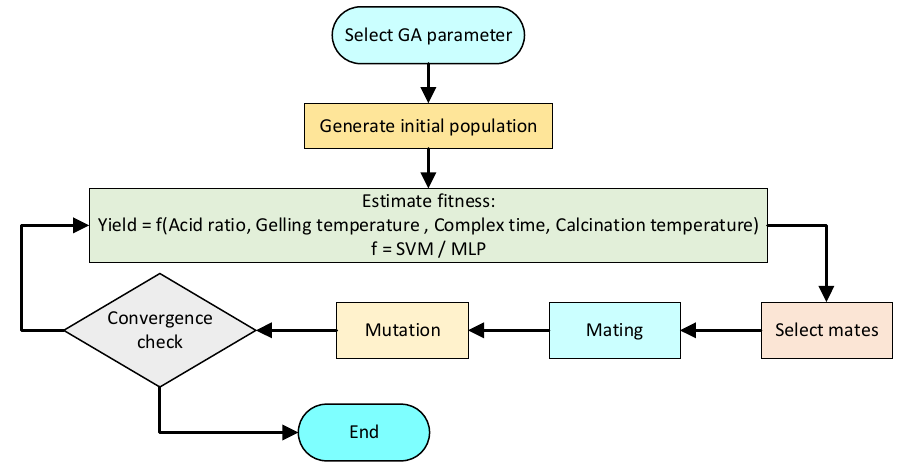
Figure 12. Genetic algorithm structure for maximising the yield.